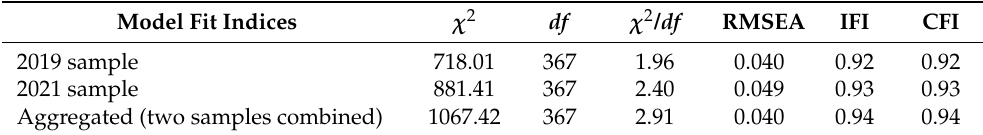
Table A14. Measurement model assessment